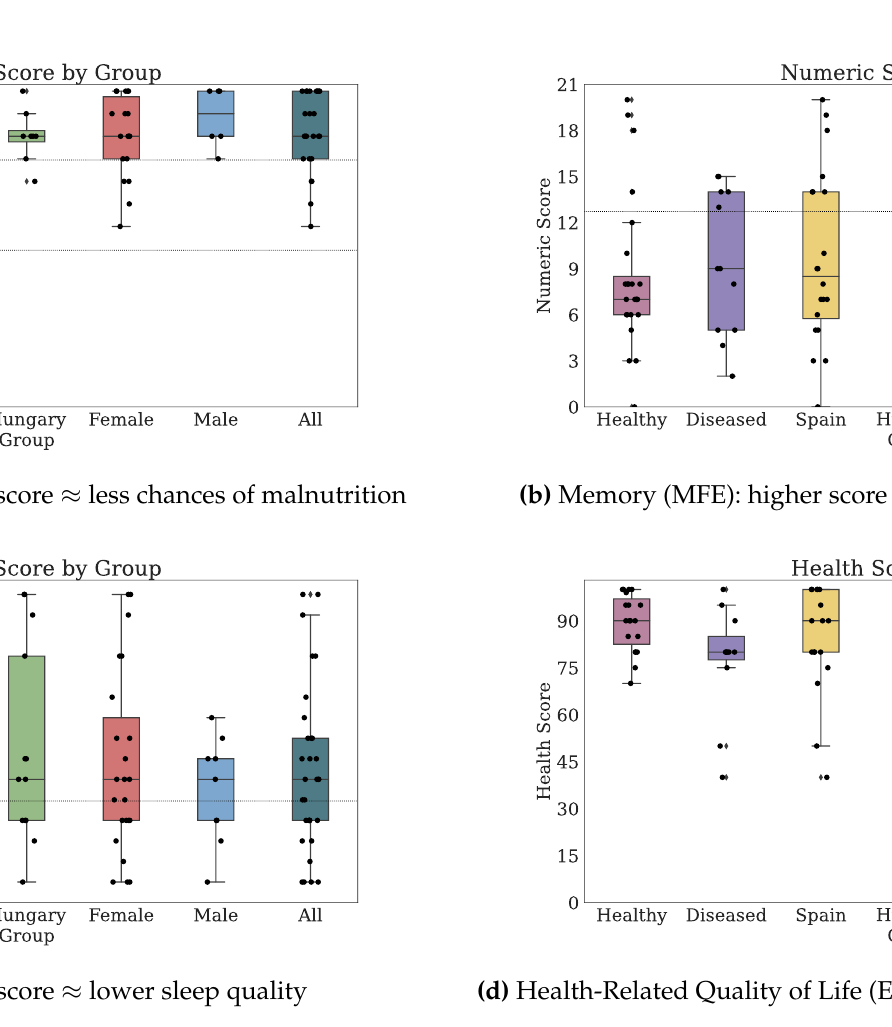
Figure 3. Numeric scores for Nutrition, Memory, Sleep, and Health-Related Quality of Life. Dotted markings delimit levels of the categorical score, where available (2 of 2)